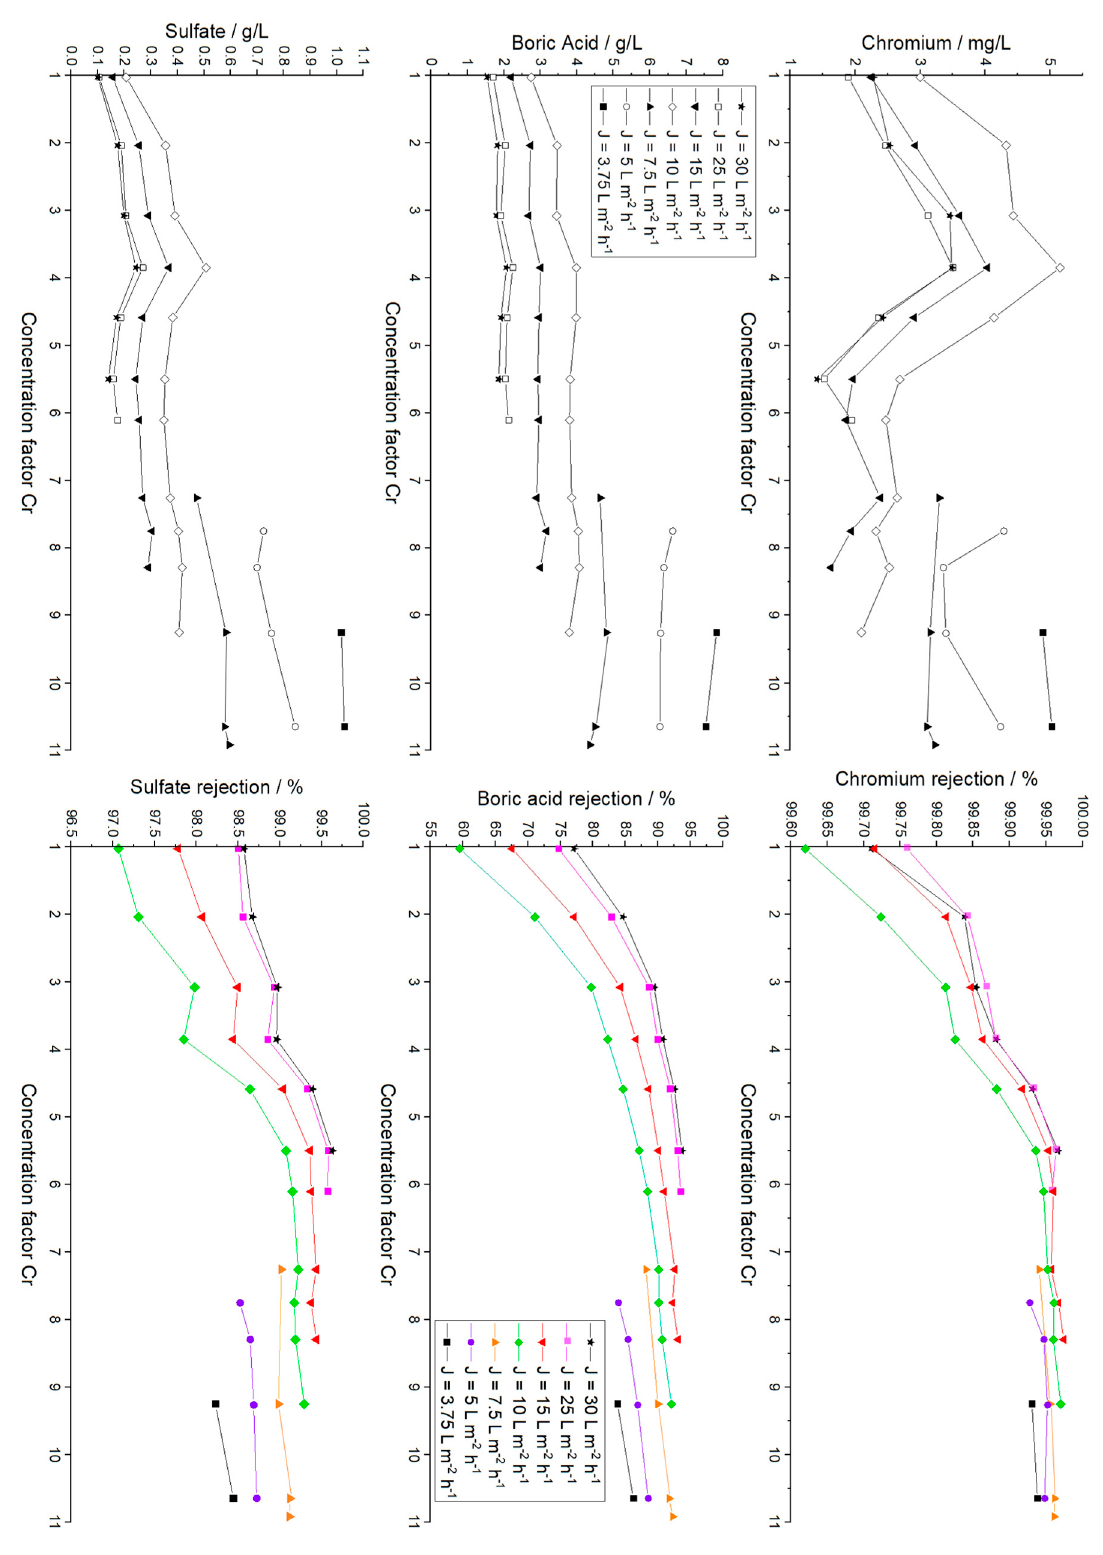
Figure 7. Mass concentration of main inorganic components in RO permeates for different permeate fluxes J and chromium concentrations factors (left) and corresponding solute rejection values (right). The errors for the mass concentrations in permeates are as follows: Cr: ≤ 2.3%, sulfate: ≤ 3.6%, boric acid: ≤ 4.6%. The errors for the rejections are as follows: Cr: ≤ 3.5%, sulfate: ≤ 4.3%, boric acid: ≤